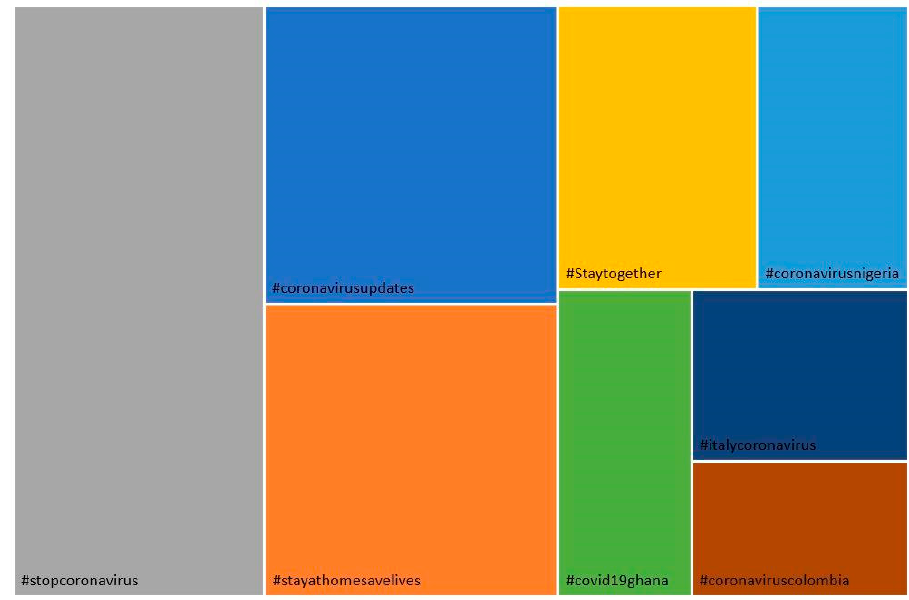
Figure 12. Other hashtags used in tweets.